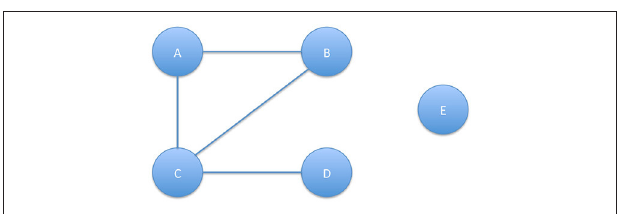
FIGURE 30 | Collaboration graph.